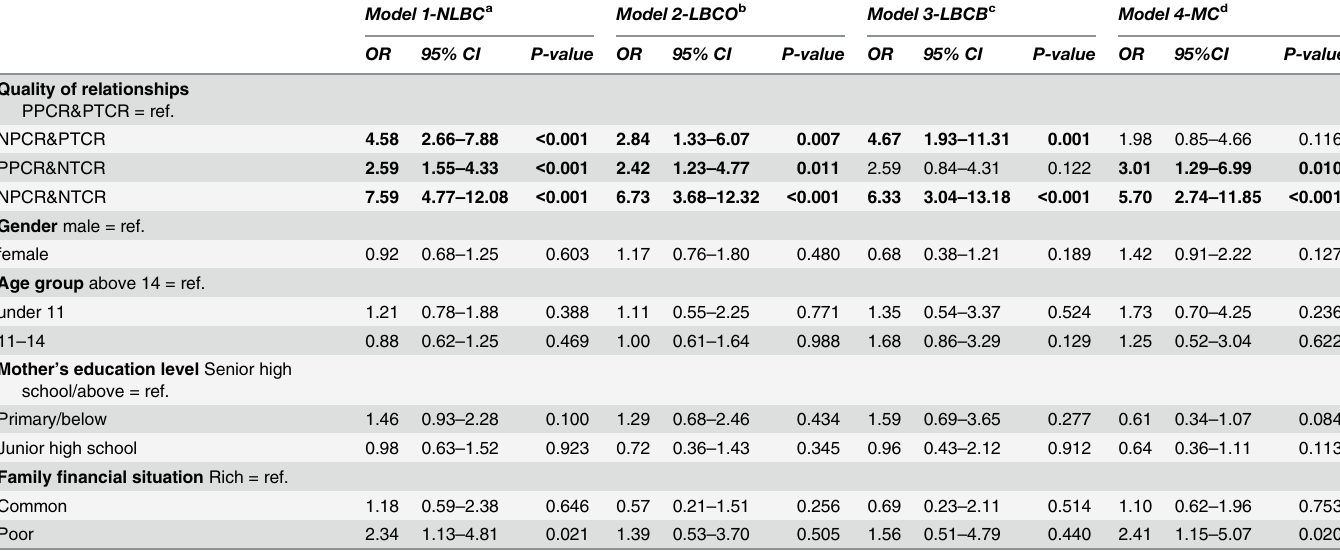
Table 5. Regression analysis for depression by interpersonal relationship quality among NLBC, LBC and